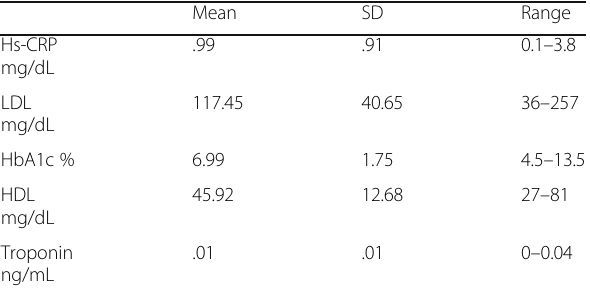
Table 4 Mean value of Hs-CRP, LDL, HbA1c, HDL, and troponin among